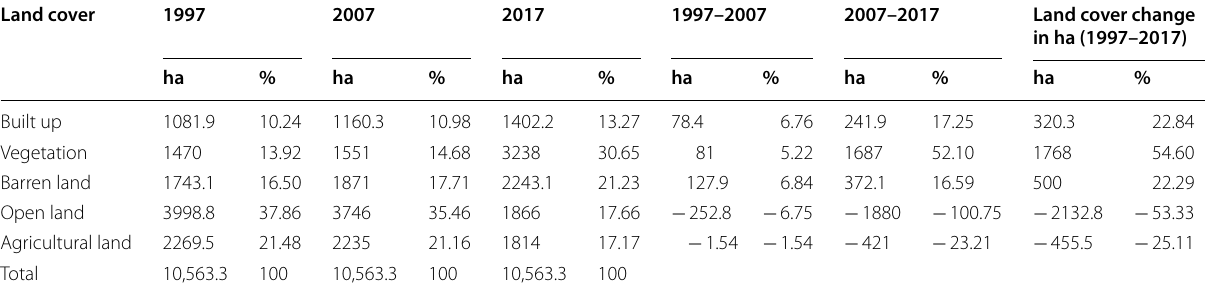
Table 3 Summary of Jimma city land covers matrix statistics for 1997, 2007, and 2017 Land cover